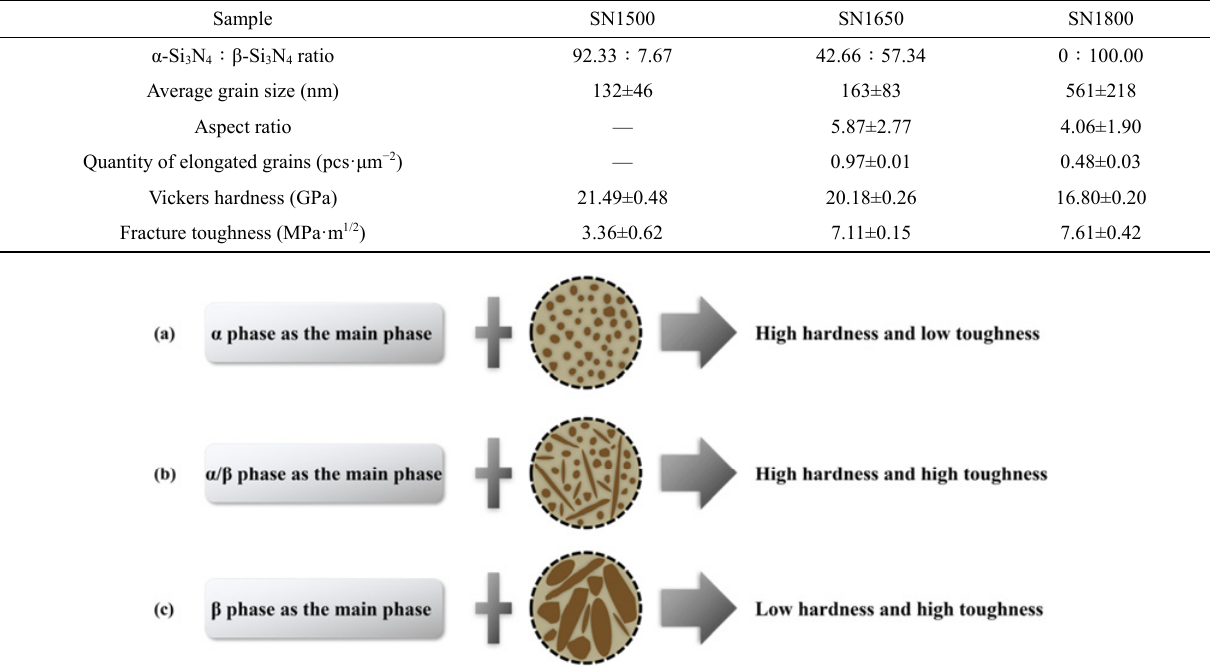
Fig. 8 Schematic diagram of mechanical properties of Si 3 N 4 ceramics controlled by phase composition and